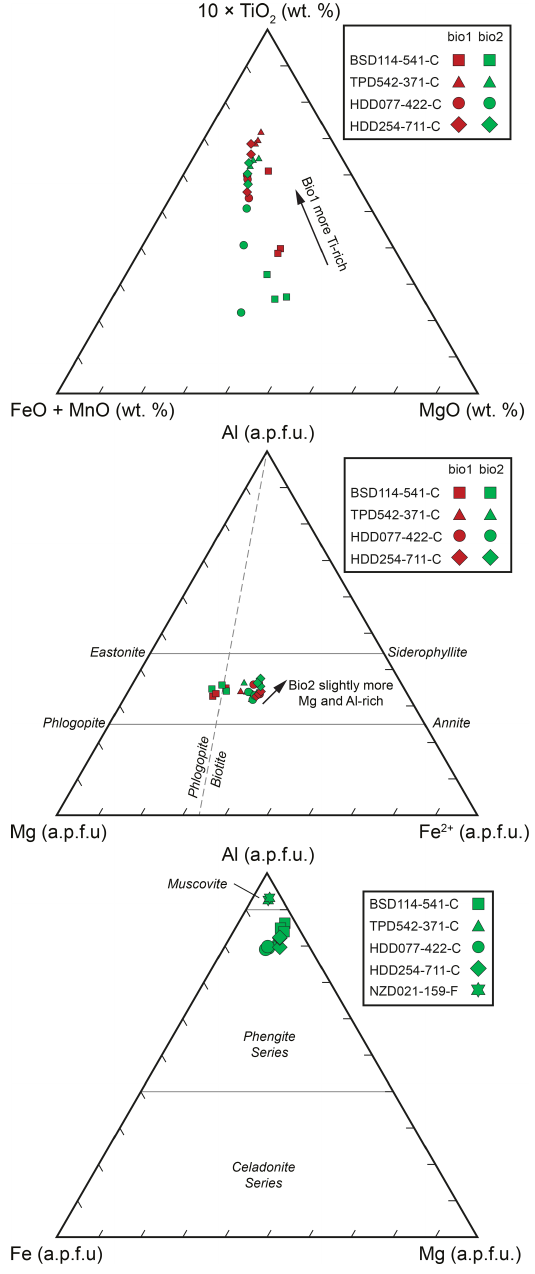
Figure 5. Mica chemistry and classifications for (a) trioctahedral mica (phlogopite–biotite series), showing elevated Ti concentra- tions in biotite 1, (b) trioctahedral micas (phlogopite–biotite series), and (c) dioctahedral micas (white mica series). Three representative analyses were taken for each phase. Note that data were obtained us- ing standardized electron dispersive X-ray spectrometer (EDS) data associated with TIMA analyses, so these data should be treated as semiquantitative only. EDS data may be found in Supplement Ta- ble S2. Note that a mgli–feal diagram after Tischendorf et al. (1997) for biotite was not used due to the extraneous presence of exsolved Ti